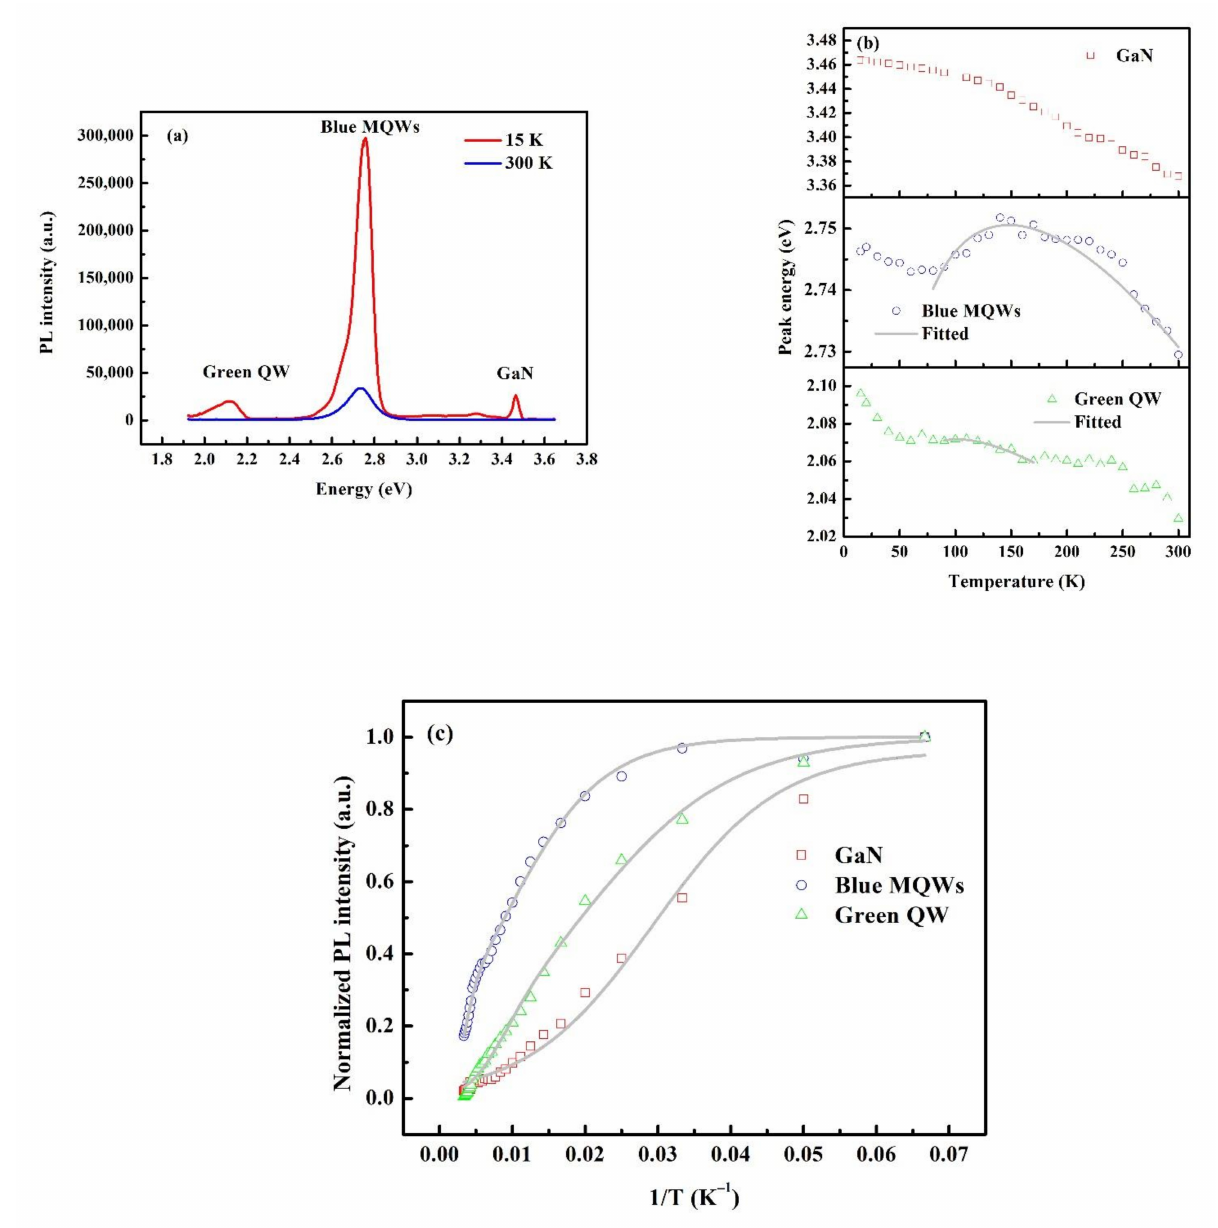
Figure 4. ( a ) The PL spectra at 15 K and 300 K. ( b ) The peak energy changes with temperature. The blue MQWs and green QW show an S-shaped curve, indicating the existing of localized states. The light grey lines are the fitted lines by the band-tail Varshni equation. ( c ) The normalized PL integral intensity vs. temperature. The light grey lines are the fitted